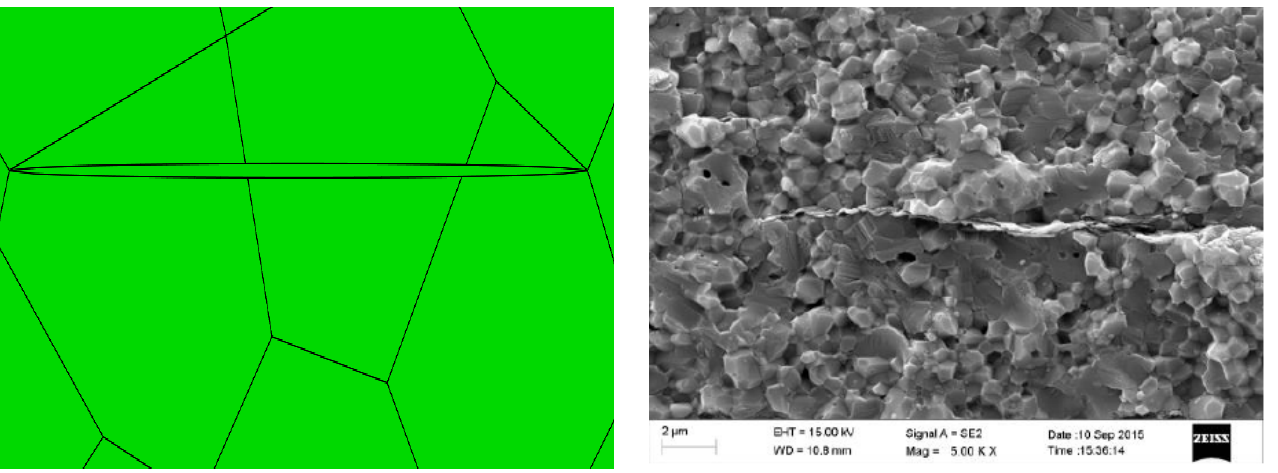
Figure 7. The microstructure of AG composite ceramic tool material [36]. Through the simulation and analysis, the toughening modes such as crack deflection, graphene fracture, and crack bridging are observed in the composite ceramic tool material. As shown in Figure 8a, the graphene sheet is tightly bonded with the matrix, and graphene is broken by cracks, which consumes a lot of fracture energy. In Figure 8b, because of the uneven dispersion of graphene, the bonding between the graphene sheet and matrix is not particularly tight, thus forming crack bridging. The simulation results are consistent with the previous experimental results of the research group, which shows that the model established in this paper is feasible.